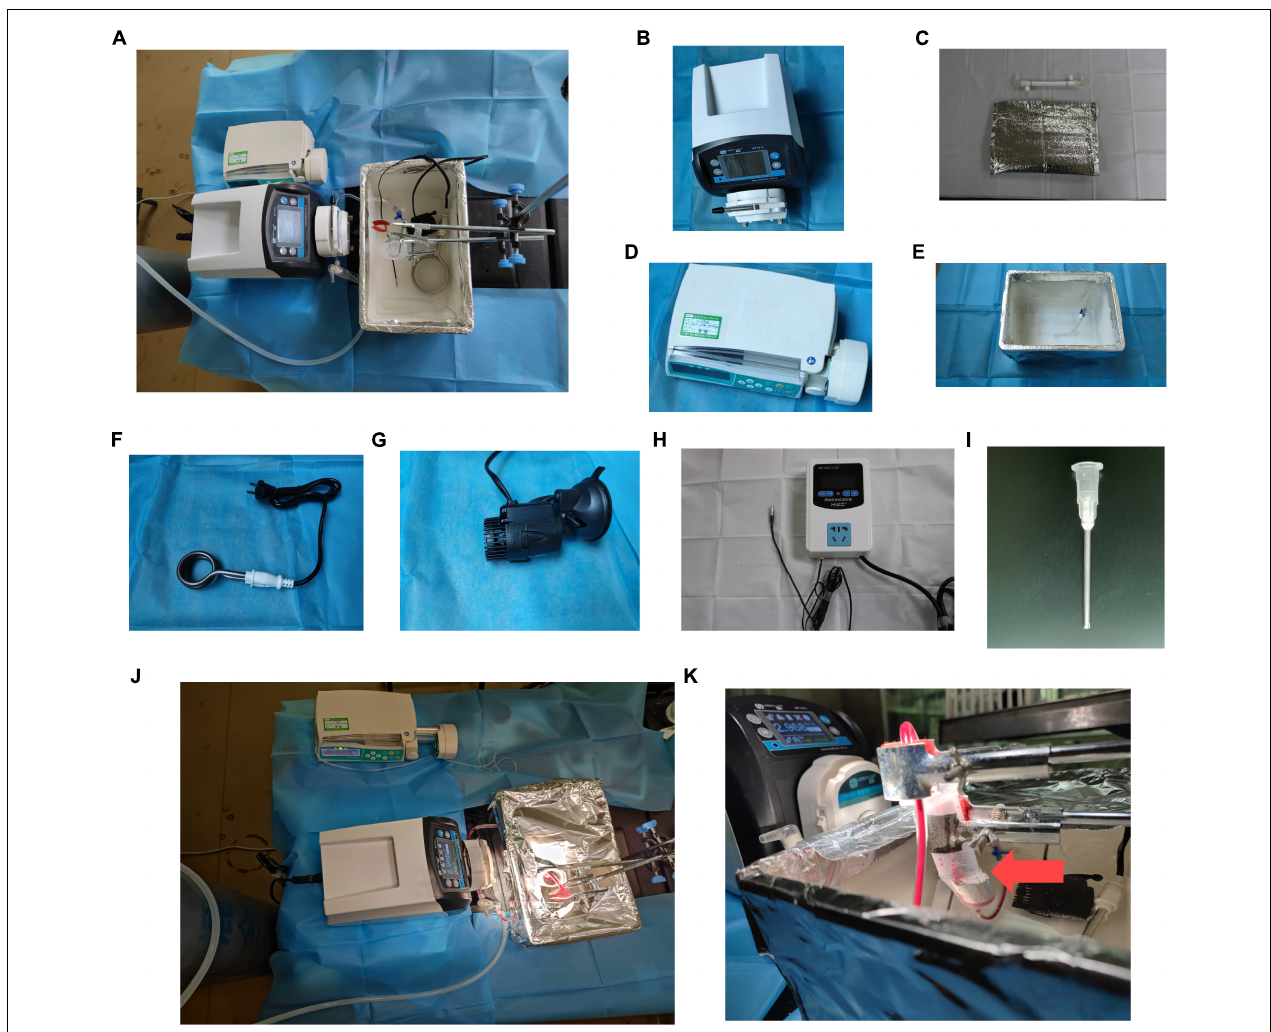
FIGURE 2 | Ex vivo heart perfusion system. (A) Schematic figure of the EVHP system; (B) micro-peristaltic pump; (C) oxygenator; (D) infusion syringe pump; (E) water-bath box; (F) heater; (G) stirrer; (H) temperature-controlling switch; (I) aortic catheter; (J) working EVHP system; and (K) beating heart (red arrow). EVHP, ex vivo heart